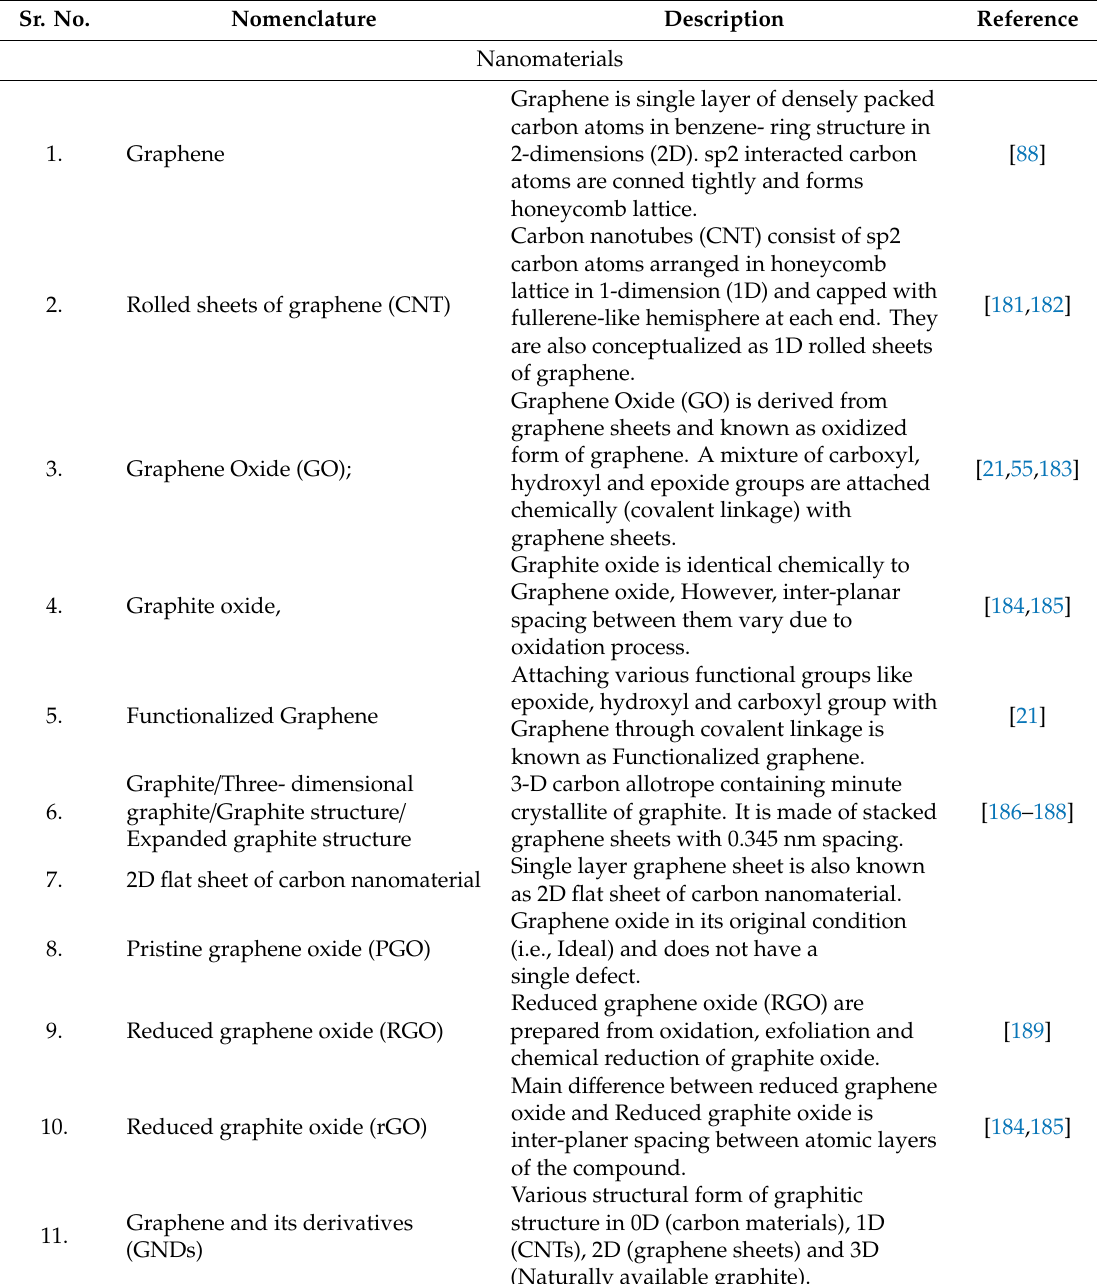
Table 5. Description of Graphene and its